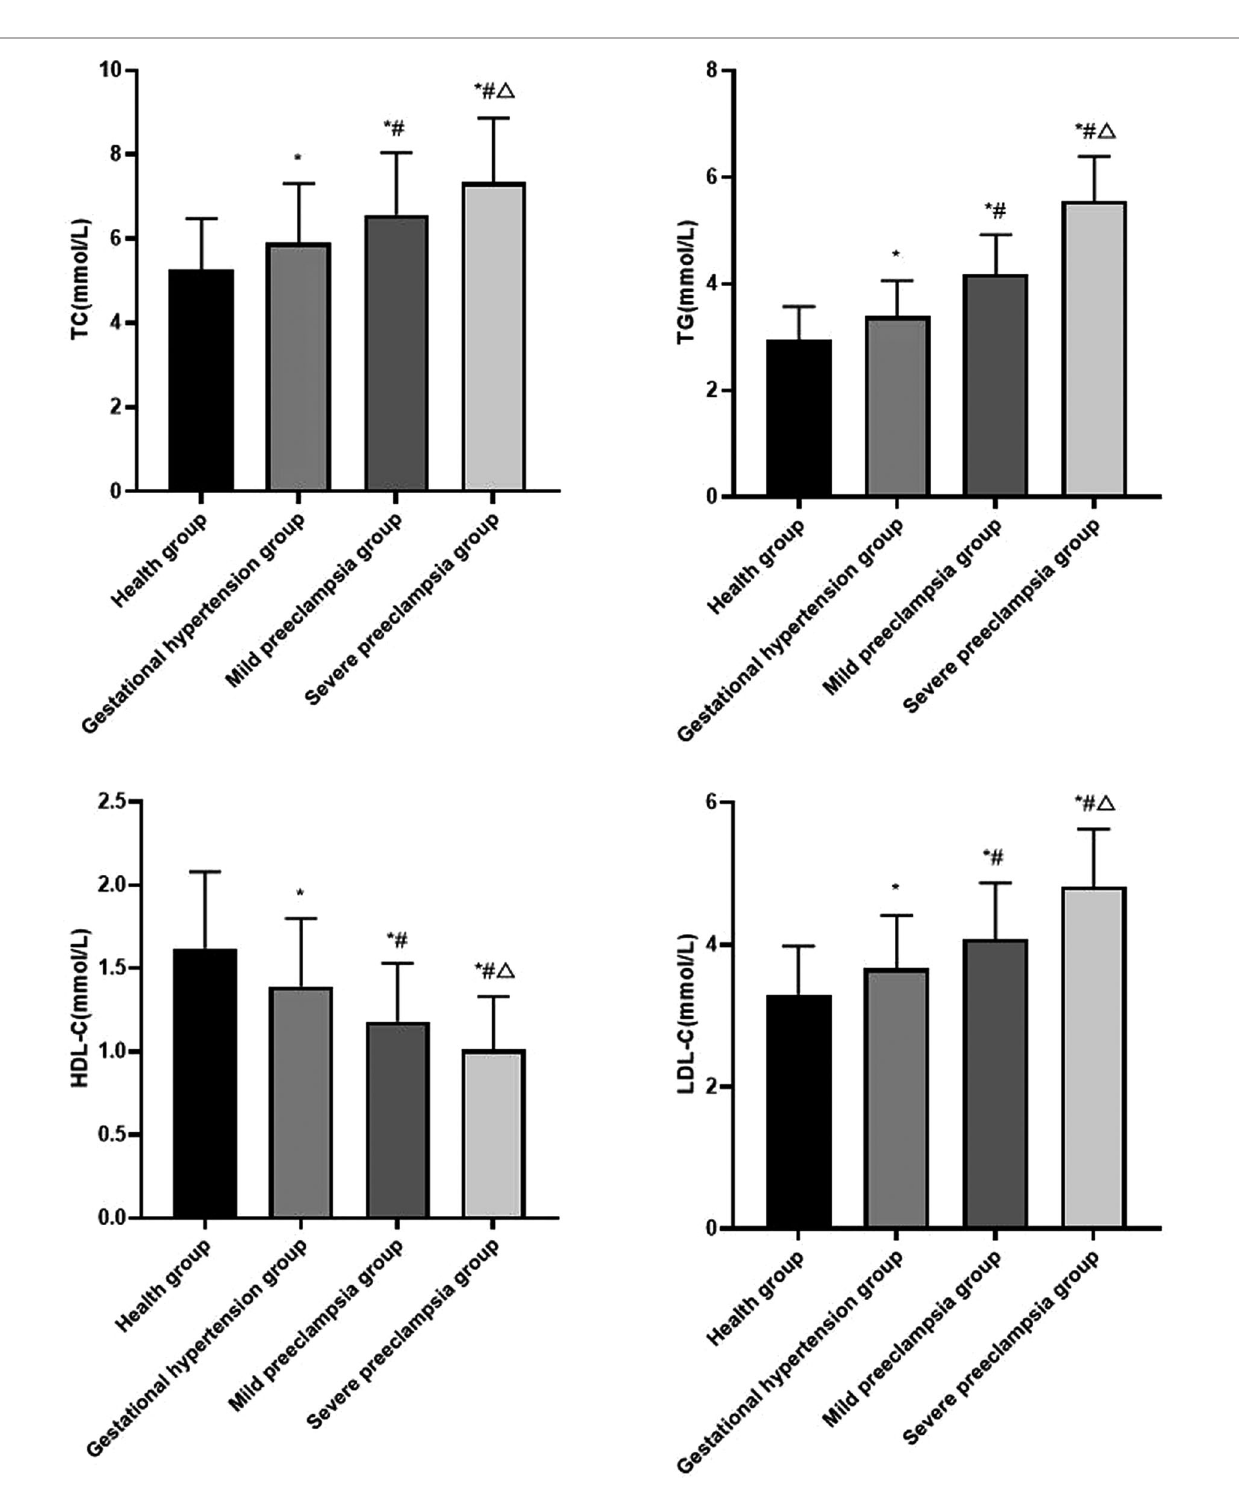
FIGURE 1 | Comparison of blood lipid levels in each group Compared with healthy group, * P <0.05; Compared with gestational hypertension group, # P <0.05; Compared with mild preeclampsia group, △ P <0.05.